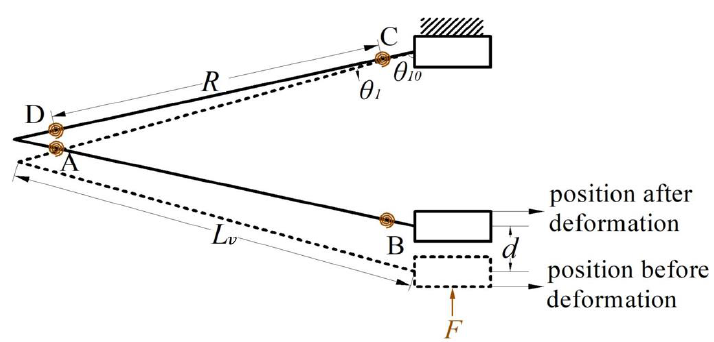
Figure 3. Pseudo-rigid body model of the V-shaped beam.